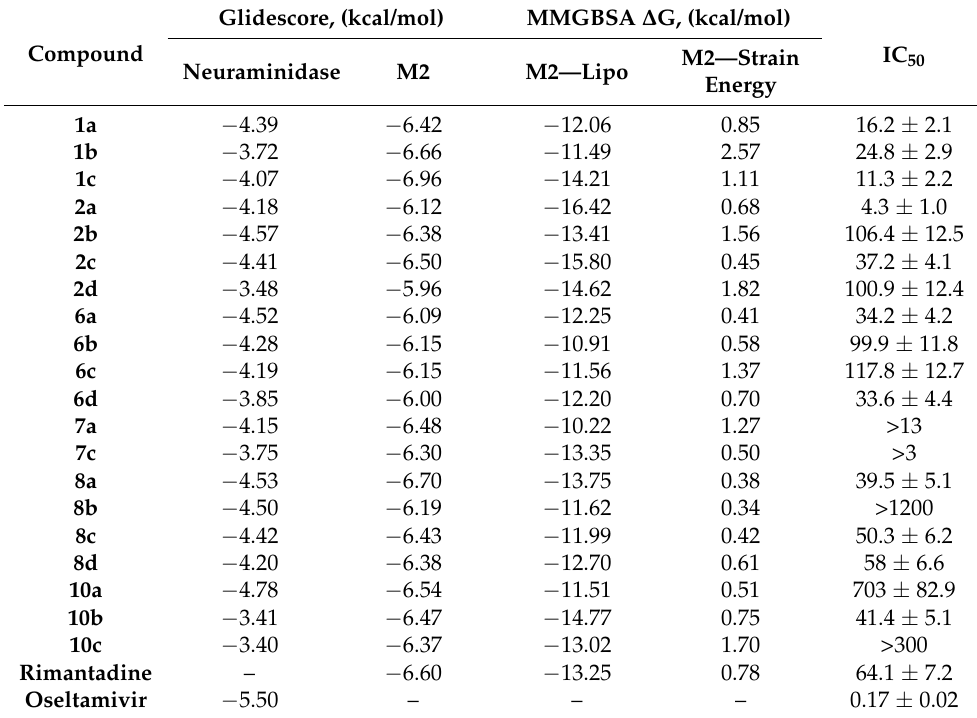
Table 3. Glide score values and MM-GBSA free energy components calculated for best-fitting binding poses of observed ligands in comparison with IC 50 values.